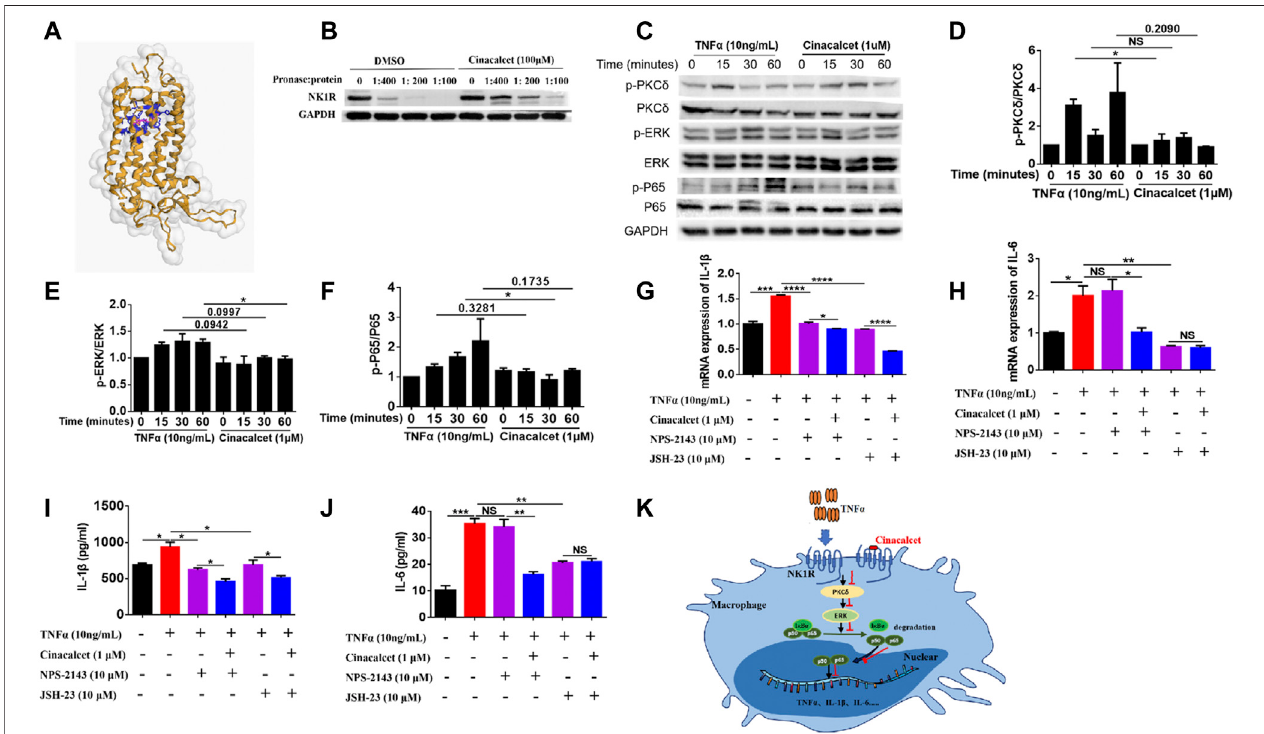
FIGURE 6 | Cinacalcet suppresses the PKC δ /ERK/P65 signaling pathway. (A) Visualization of predicted the binding sites of cinacalcet with respect to NK1R. Structureson theyellow colorand grey surface represent the NK1R structure, blue structures representthe aminoacidsofcinacalcet that bindtoNK1R, and structures in pink represent structures of cinacalcet. (B) DARTs assay to test the binding of NK1R and cinacalcet. (C) Representative western blot results to show that cinacalcet suppressesthePKC δ /ERK/P65signalingpathway.Bonemarrow-derivedmacrophages(BMDMs)werestarvedwith2%FBSovernight.Aftertreatingthecellswith cinacalcet (1 μ M) for 2 h, TNF α (10 ng/ml) was added for different periods (0, 15, 30, 60 min). Proteins were extracted from the cells, and western blotting was performed. (D) Quanti fi cation of p-PKC δ expression. (E) Quanti fi cation ofp-ERK expression. (F) Quanti fi cation ofp-P65 expression. (G, H) qRT-PCRwasperformed to test the mRNA expression levels of IL-1 β and IL-6 in BMDMs after stimulation with TNF α (10 ng/ml) in the presence or absence of cinacalcet for 24 h (I, J) ELISA was performed to detect IL-1 β and IL-6 levels in BMDM supernatants after stimulation with TNF α (10 ng/ml) in the presence or absence of cinacalcet for 24 h. (K) Proposed model explaining the anti-TNF activity ofcinacalcet through direct targeting ofthe NK1R pathway. * p < 0.05, ** p < 0.01, *** p < 0.001, **** p < 0.0001. Data are shown as the mean with standard deviation. Three independent experiments were